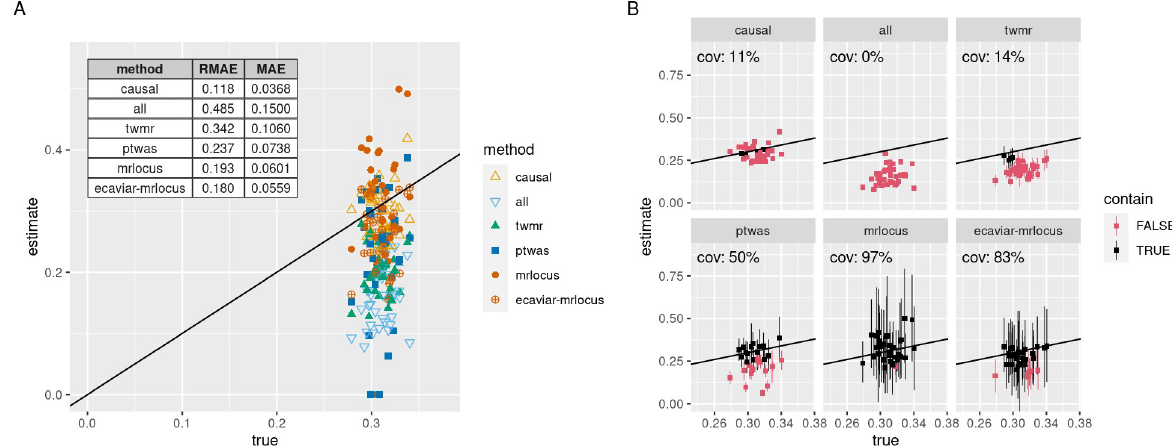
Fig 2. Performance of methods on simulated eQTL and GWAS datasets. (A) Estimates of each method over true (simulated) gene-to-trait values. The method denoted with “causal” indicates an inverse variance weighted slope estimation using the true causal SNPs but the estimated coefficients and SEs (an oracle estimate), and “all” indicates an inverse variance weighted slope estimation using all SNPs. (B) Observed coverage (abbreviated “cov.”) of 80% confidence or credible intervals from each method. If the interval contains the true effect size, it is colored black, otherwise